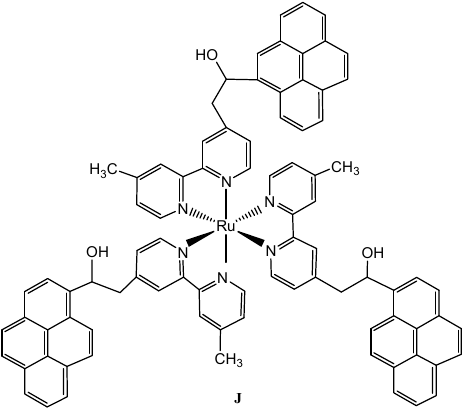
Figure 9. Molecular structure of Ru(II) bipyridine with pyrenyl chromophores ( J ) [79].